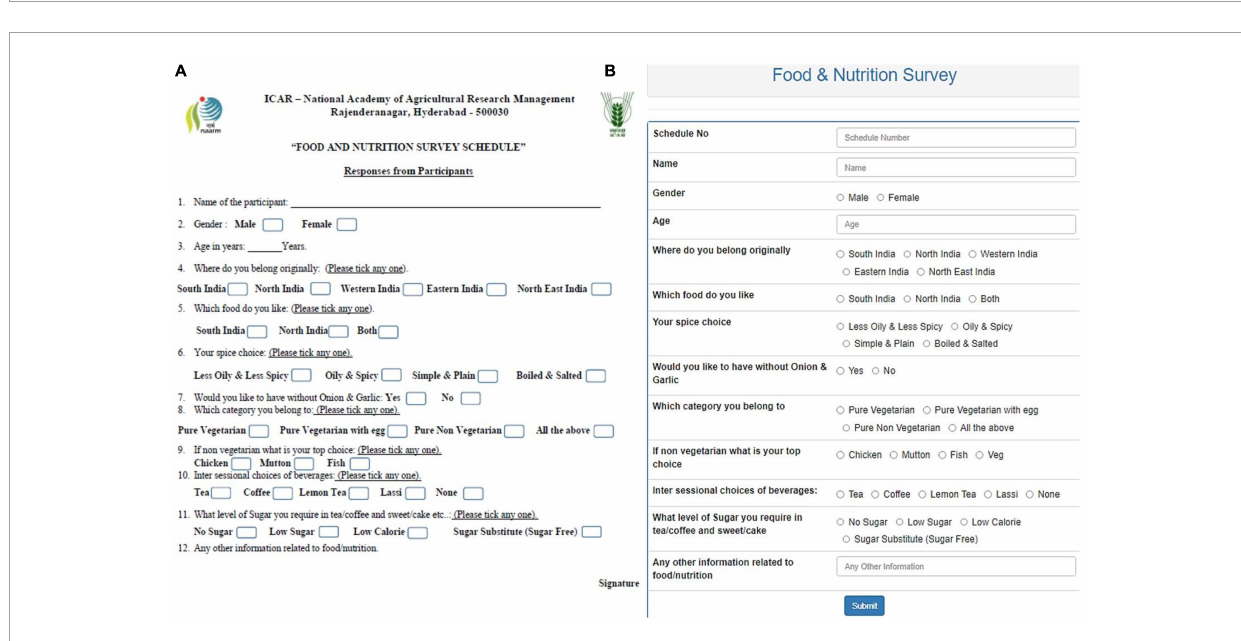
FIGURE4 (A) Questionnaire on Food and Nutrition Survey Schedule. (B) Questionnaire